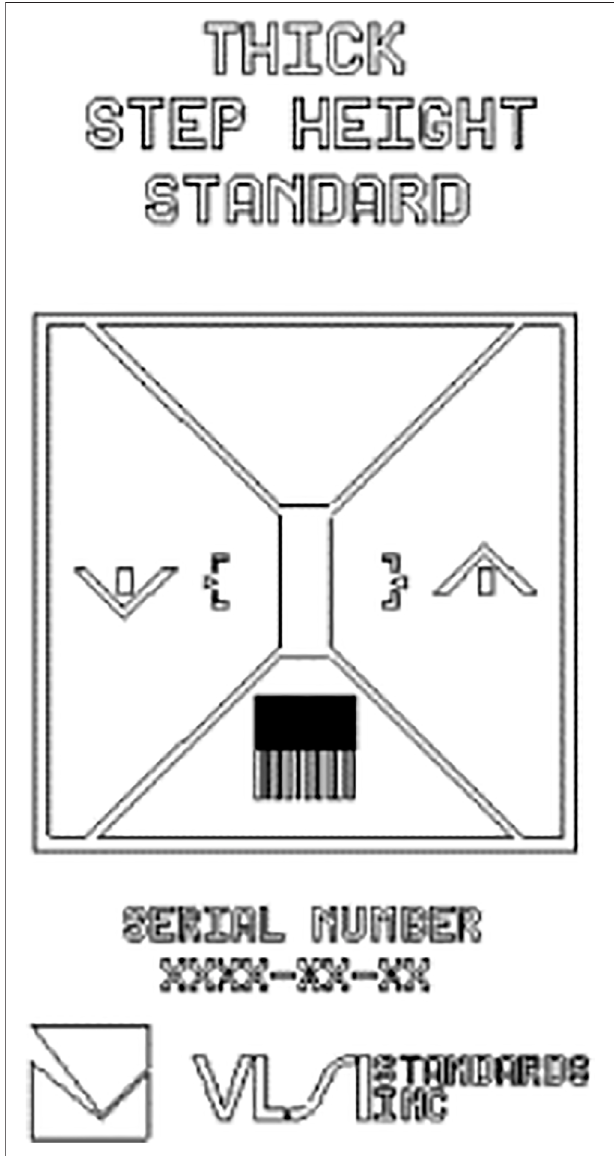
FIGURE 2 | Schematic diagram of VLSI step height